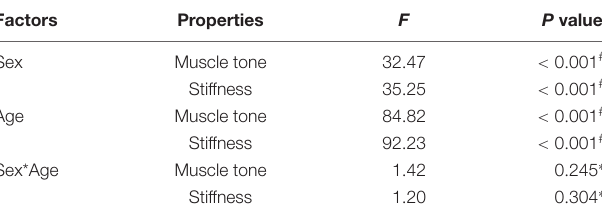
TABLE 3 | Statistical analysis results of main effects and interaction effects.